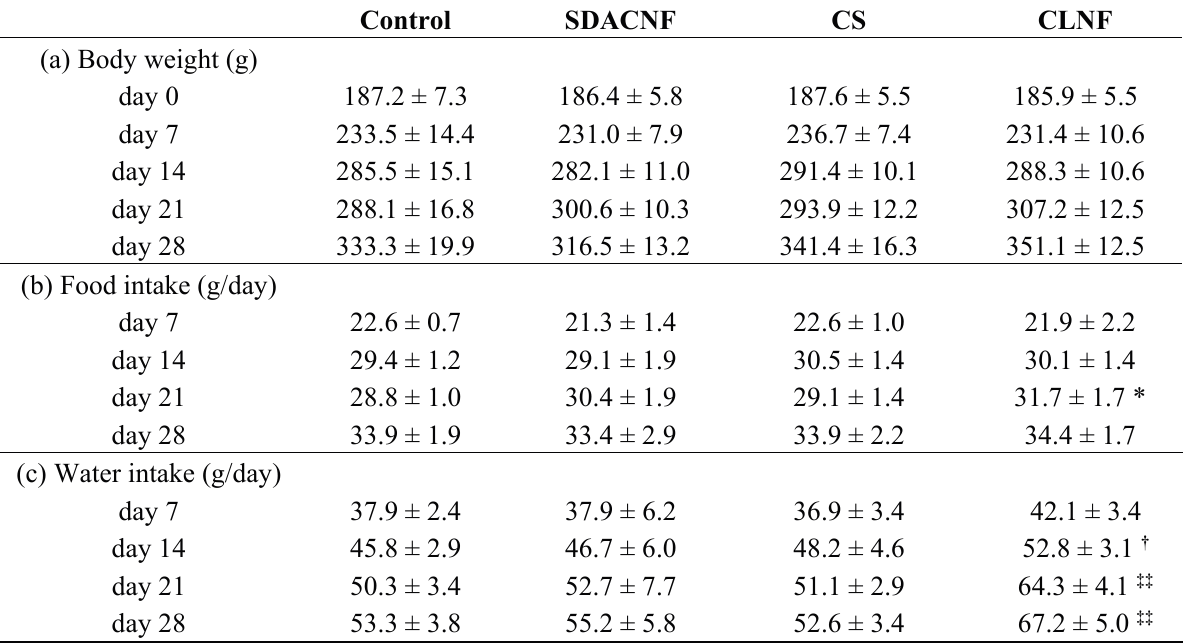
Table 1. Effects of oral administration of surface-deacetylated chitin nanofibers (SDACNFs) on body weight change and food and water intake. Each table indicates body weight ( a ), food intake ( b ), and water intake ( c ). Data are presented as mean ± standard error. *: p < 0.05 compared with the control and CS groups. † : p < 0.05 compared with the control group. ‡‡ : p < 0.01 compared with the control, CNFs and CS groups.